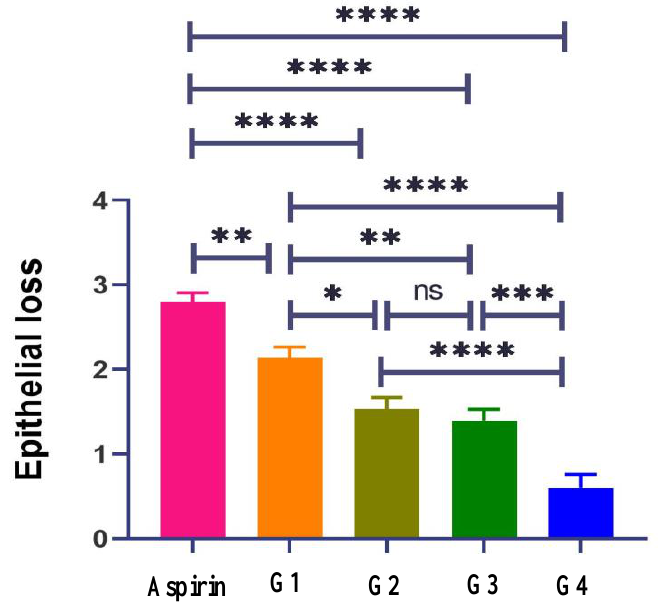
Figure 19. Epithelial loss score. Data were presented as means ± SE. * statistically significant at p ≤ 0.1, ** p ≤ 0.01, *** p ≤ 0.001, **** p ≤ 0.0001. Significance was considered at p < 0.05. ns- not significant.